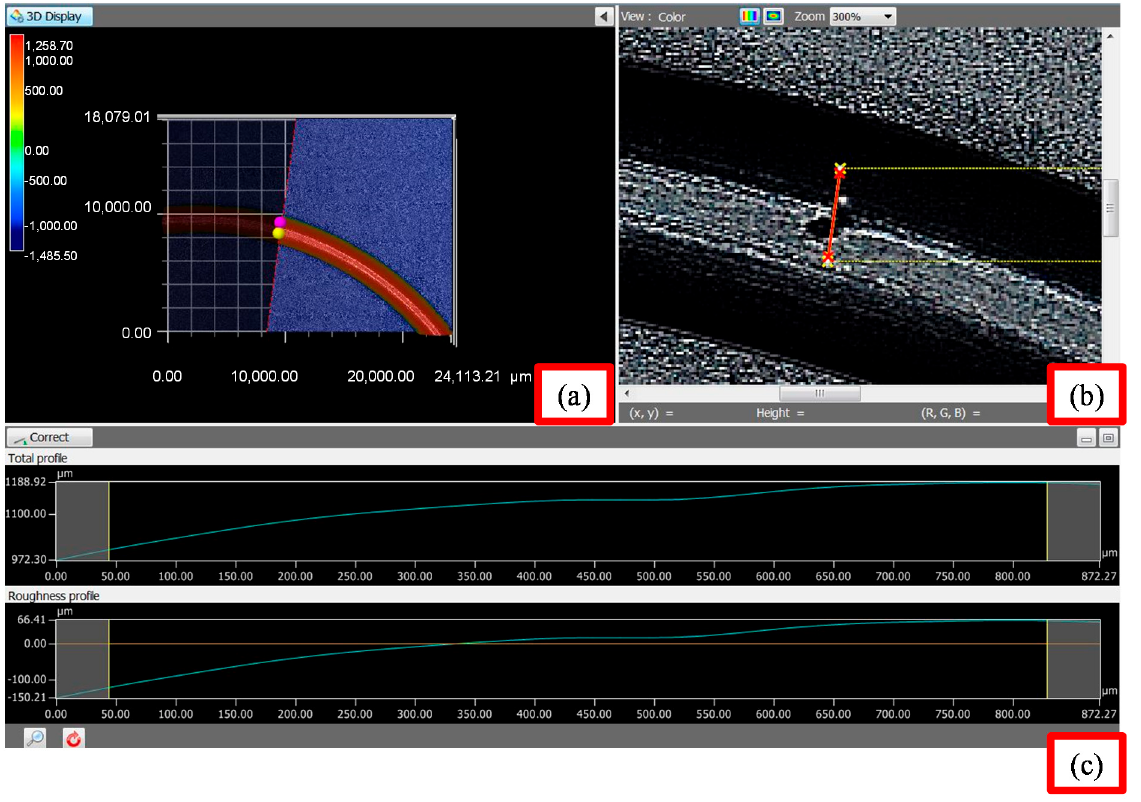
Figure 24. O-ring sample with the tiny scratched measured by optical profilometer. ( a ) 3D model of the tiny scratched; ( b ) 2D image of the tiny scratched; ( c ) Measurement result of the tiny scratched.